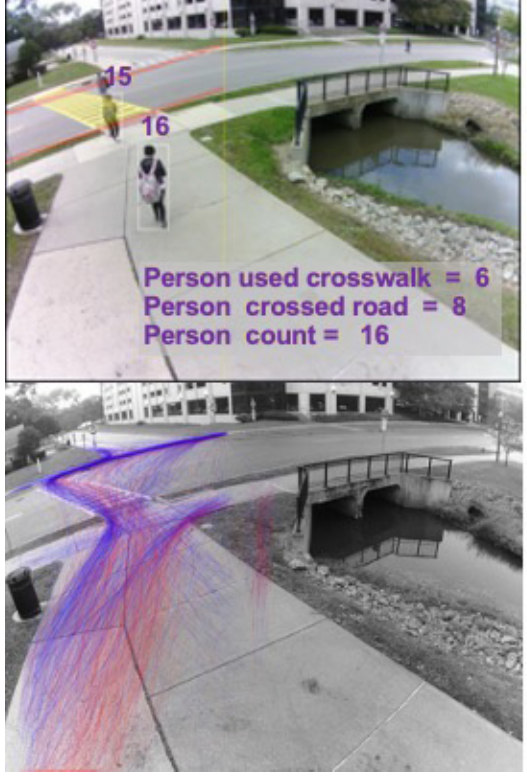
Fig. 4 Software-defined sensor to measure crosswalk usage. Images courtesy P. Bharti, D. Koop, and M. E. Papka, Northern Illinois